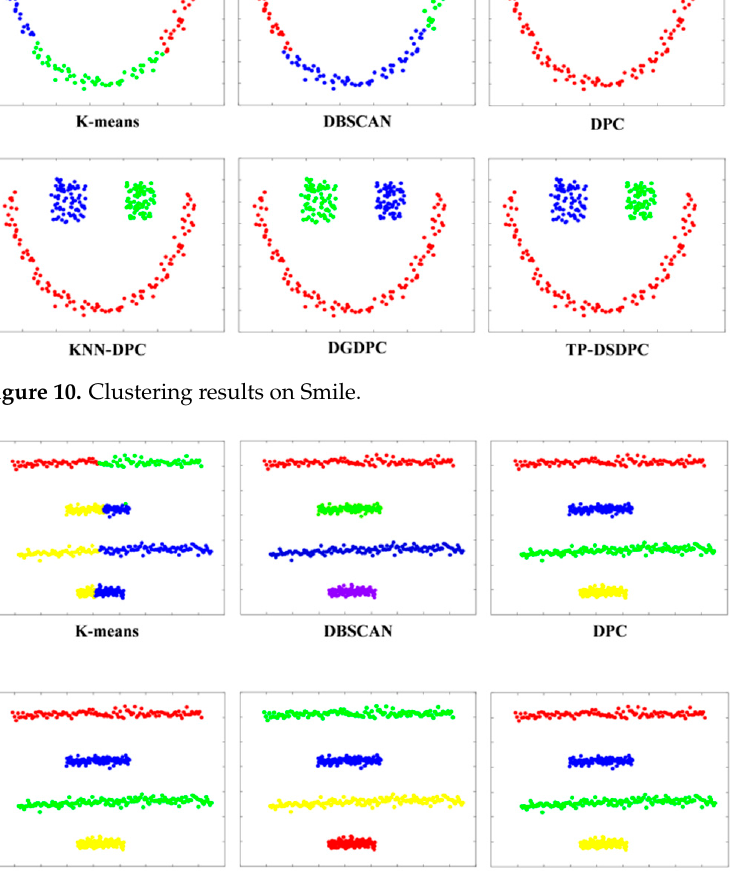
Figure 11. Clustering results on Fourlines.